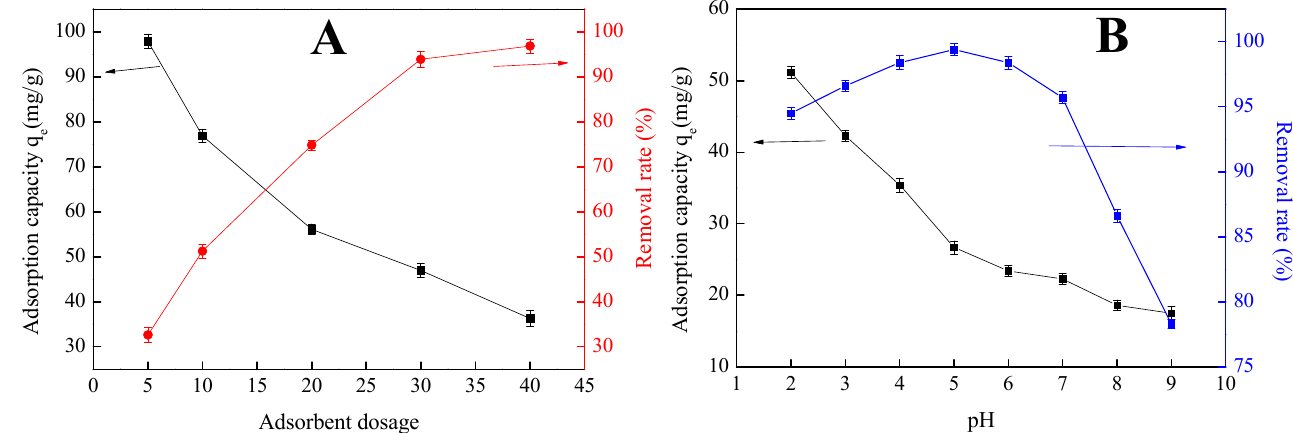
Figure 4. The effect of ( A ) adsorbent dosage and ( B ) the solution pH on phosphate adsorption capacity.